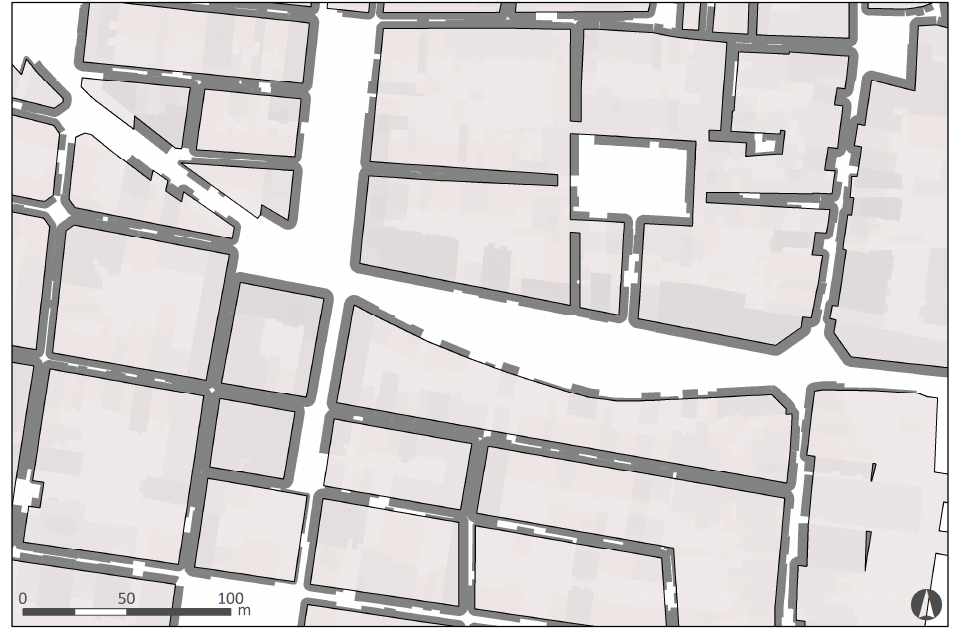
Figure 16. Apparent occlusion projected onto the ground